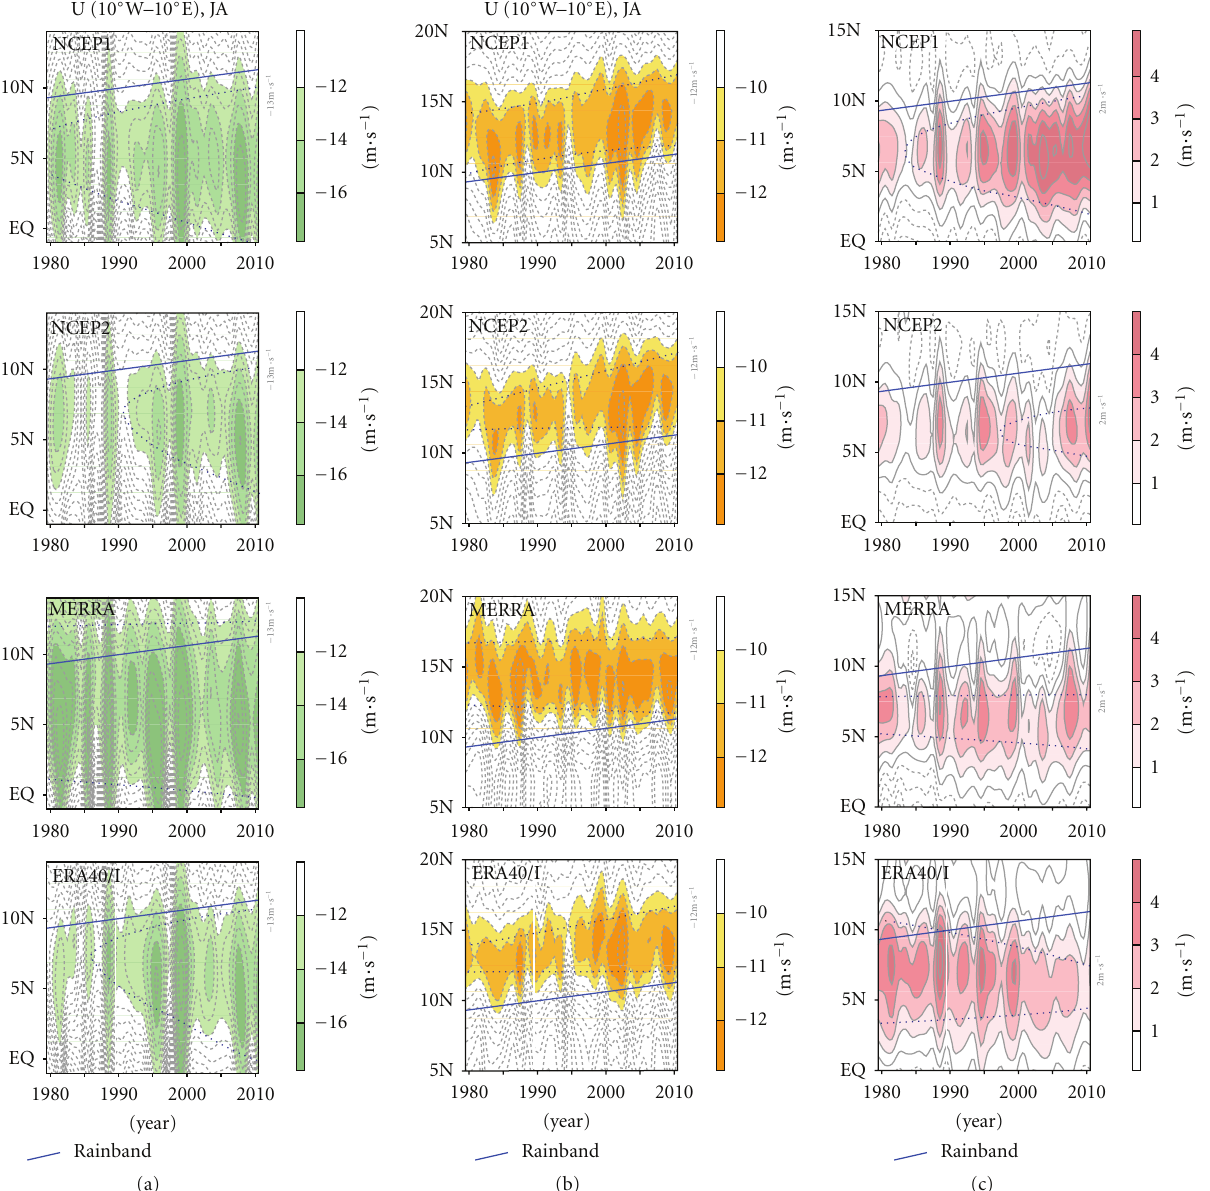
Figure 4: The same as Figure 2 but for zonal wind speeds at levels of (a) 200mb, (b) 600 mb, and (c) 850 mb derived from (top-down) NCEP1, NCEP2, MERRA, and ERA40/I. The solid blue lines indicate the Sahel rainband migration. The dotted lines indicate linear trends of the designated value. Note the di ff erent latitudinal scales for each level. In ERA40/I, year 1989 is masked out to highlight the transition from ERA40 to